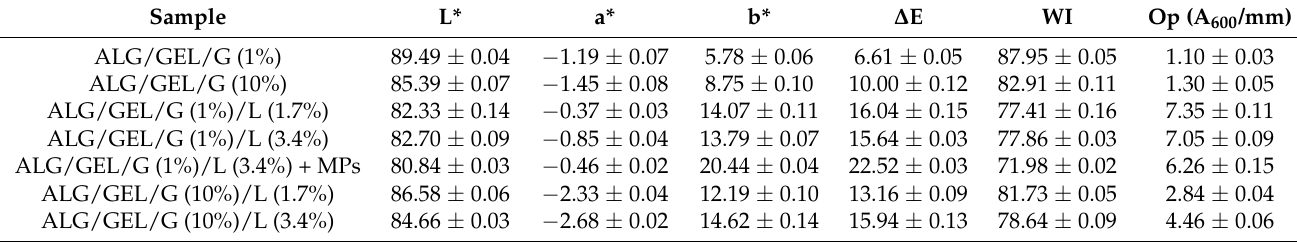
Table 3. The color values (L*a*b*), a total difference of color value ( ∆ E), whiteness index (WI) and opacity (Op) of prepared films based on sodium alginate and gelatin with different amounts of glycerol and lipids, as well as the sample with incorporated PLA